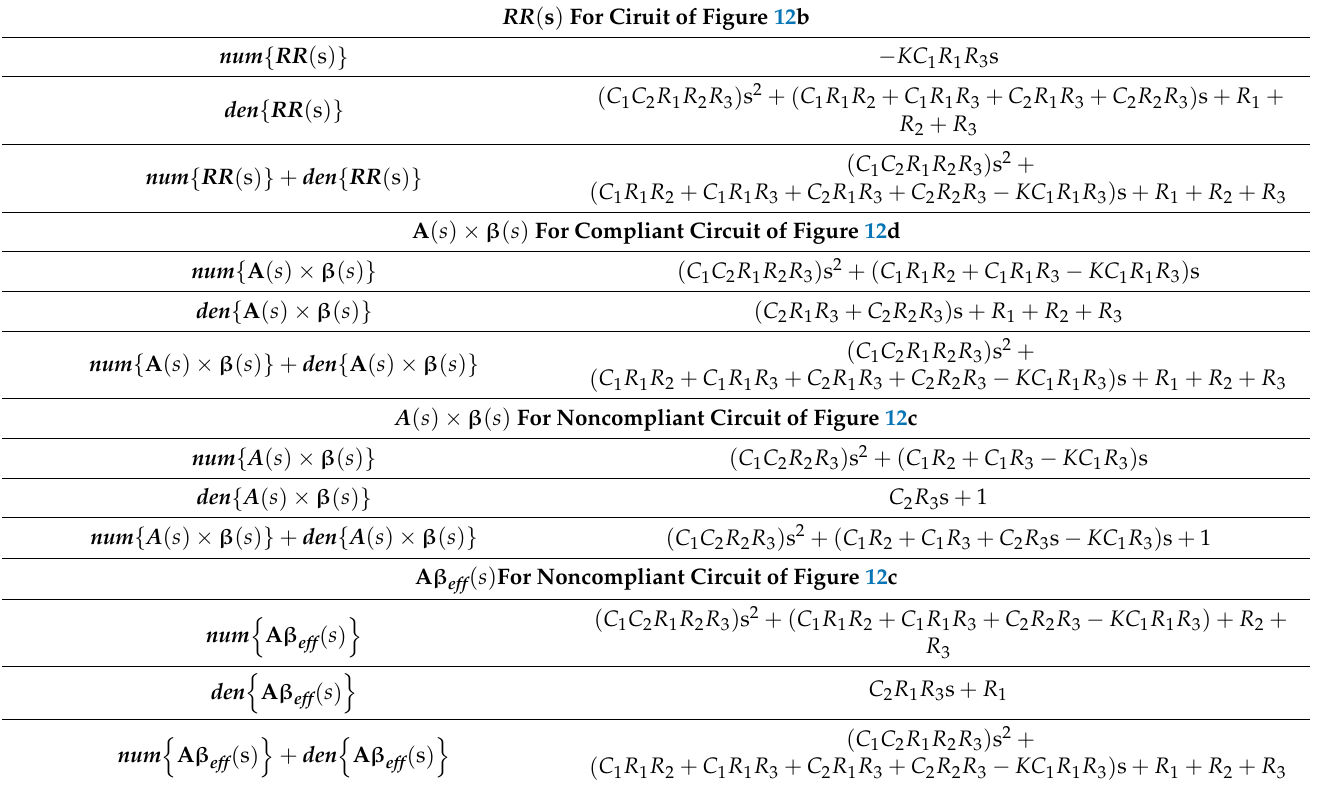
Table 1. Numerator and Denominator Terms and their Combined Sums for the Circuits of Figure 12. (Green shaded row indicates agreement; red shaded row indicates